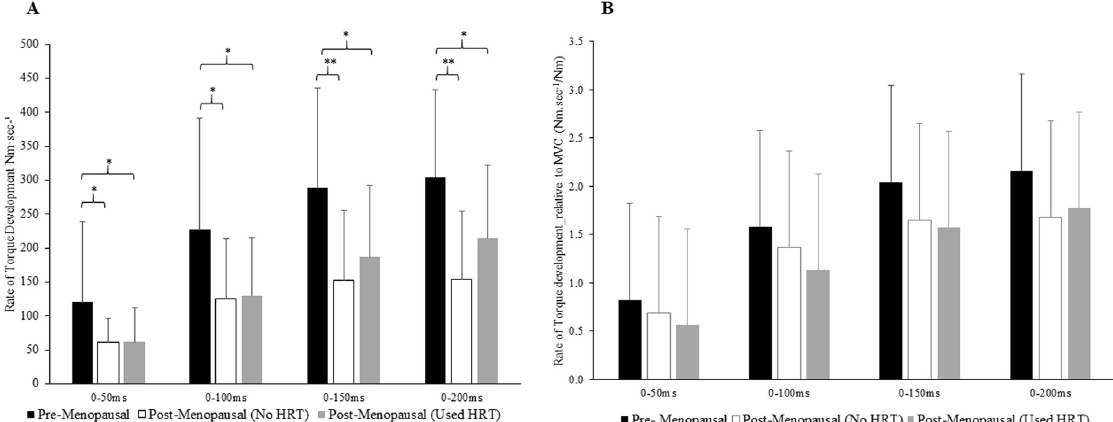
Fig 3. Comparison of participants’ plantar rate of torque development categorized by participants’ menopause phase and use of hormone replacement therapy. A) Absolute values. Values are means ± SDs. Different from Pre-Menopausal and Post-Menopausal, � P < 0.05, �� P < 0.01. B. Relative values. Values are RTD relative to each individual’s MVC. Different from Pre-Menopausal and Post-